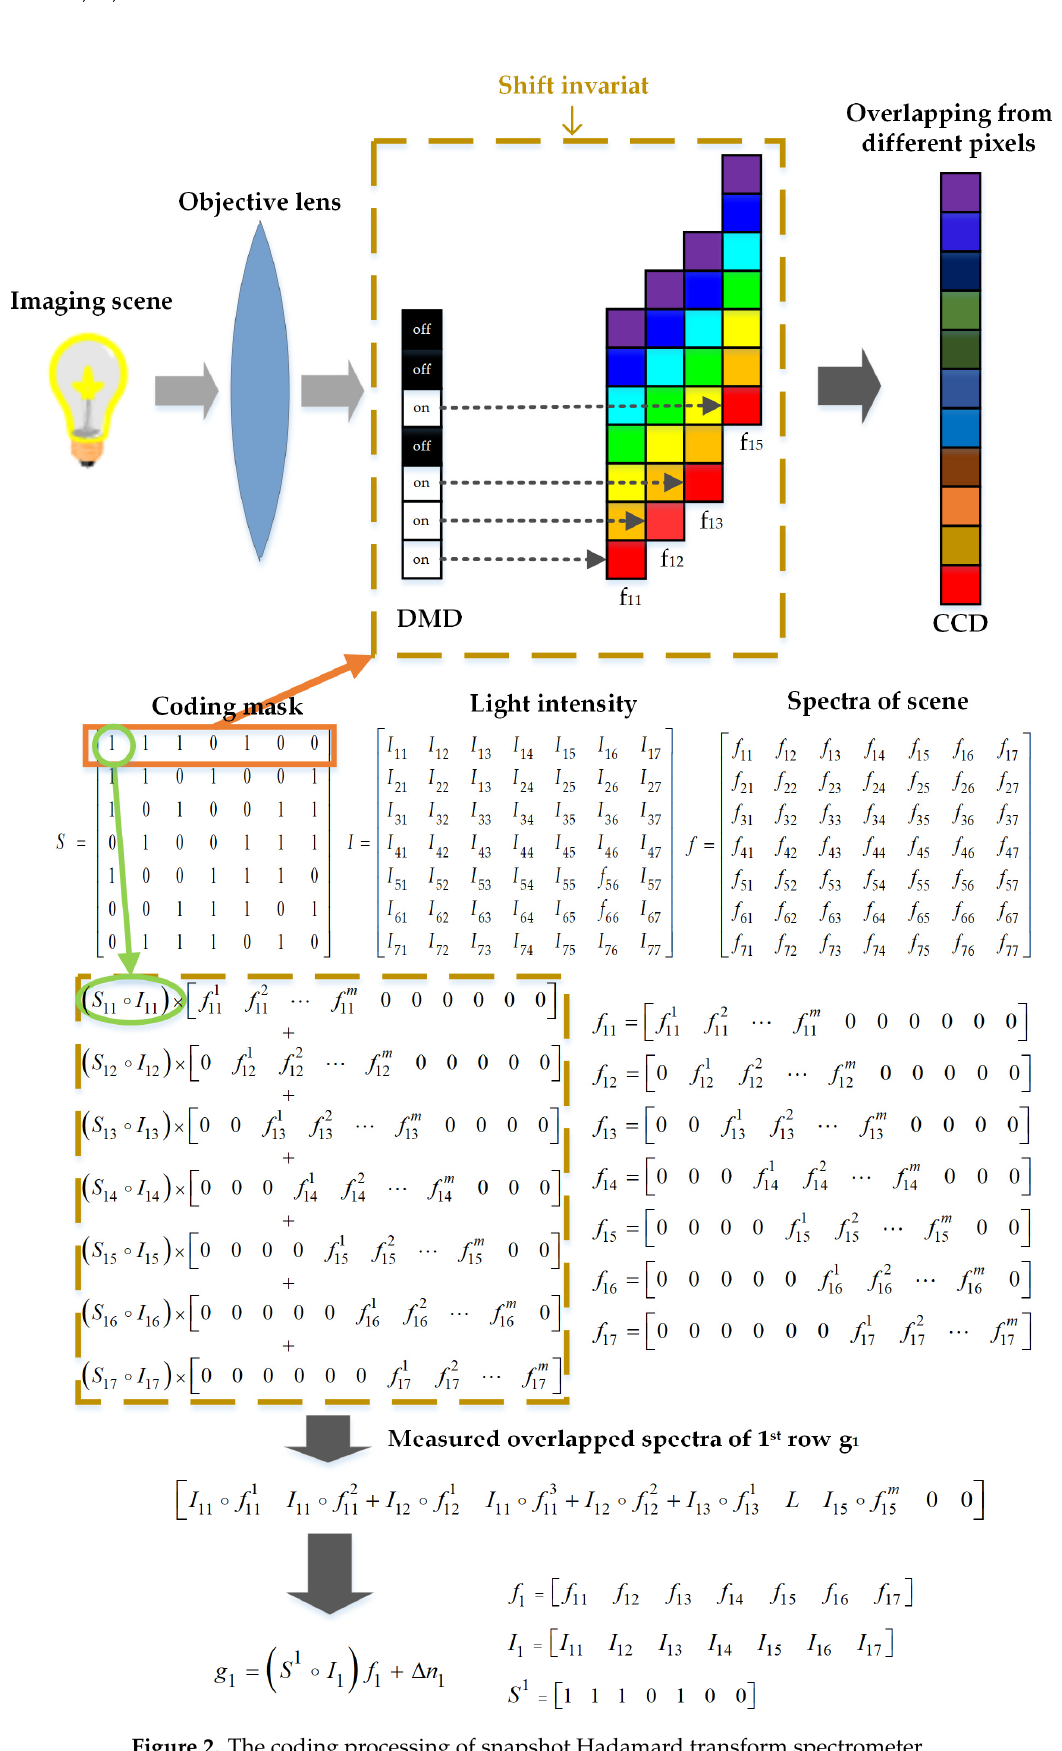
Figure 2. The coding processing of snapshot Hadamard transform spectrometer.